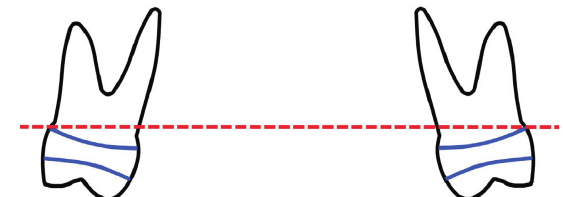
Figure 4: A schematic image of the frontal occlusal plane (the red dotted line).